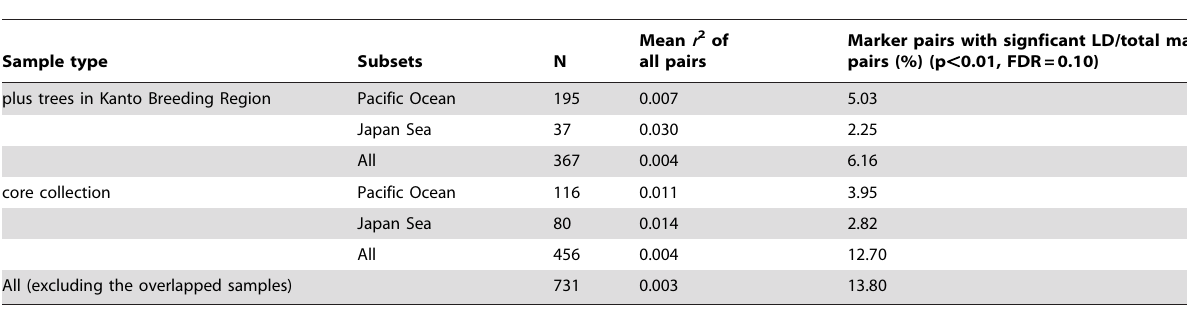
Table 1. Linkage disequilibrium (LD) pair-wise pattern of C. japonica plus trees.